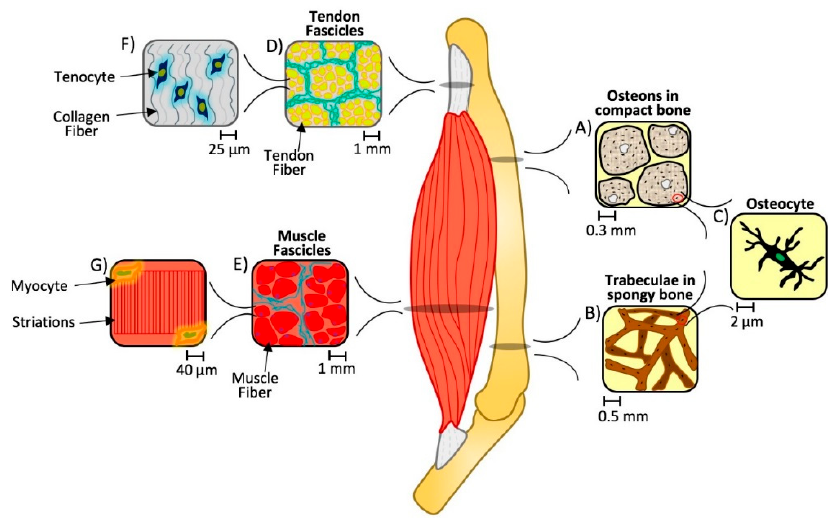
Figure 1. Multiscale hierarchical structure of bone, tendon, and muscle. An organ system consists of several organs with underlying hierarchical structures. In this case, bone ( A – C ), tendon ( D , F ), and muscle ( E , G ) units consist of unique cellular components (in the order of 2–40 µ m) that are capable of sensing and modulating the tissue-level composite architecture at various length scales (from 0.3–1 mm, depending on the tissue) under physiological conditions. When these architectures are disturbed, the normal spatial and temporal responses of these tissues to their static and dynamic biomaterial environment is disrupted and contributes to eccentric loading and ultimately injury and pathological losses in structure and function [13–18].